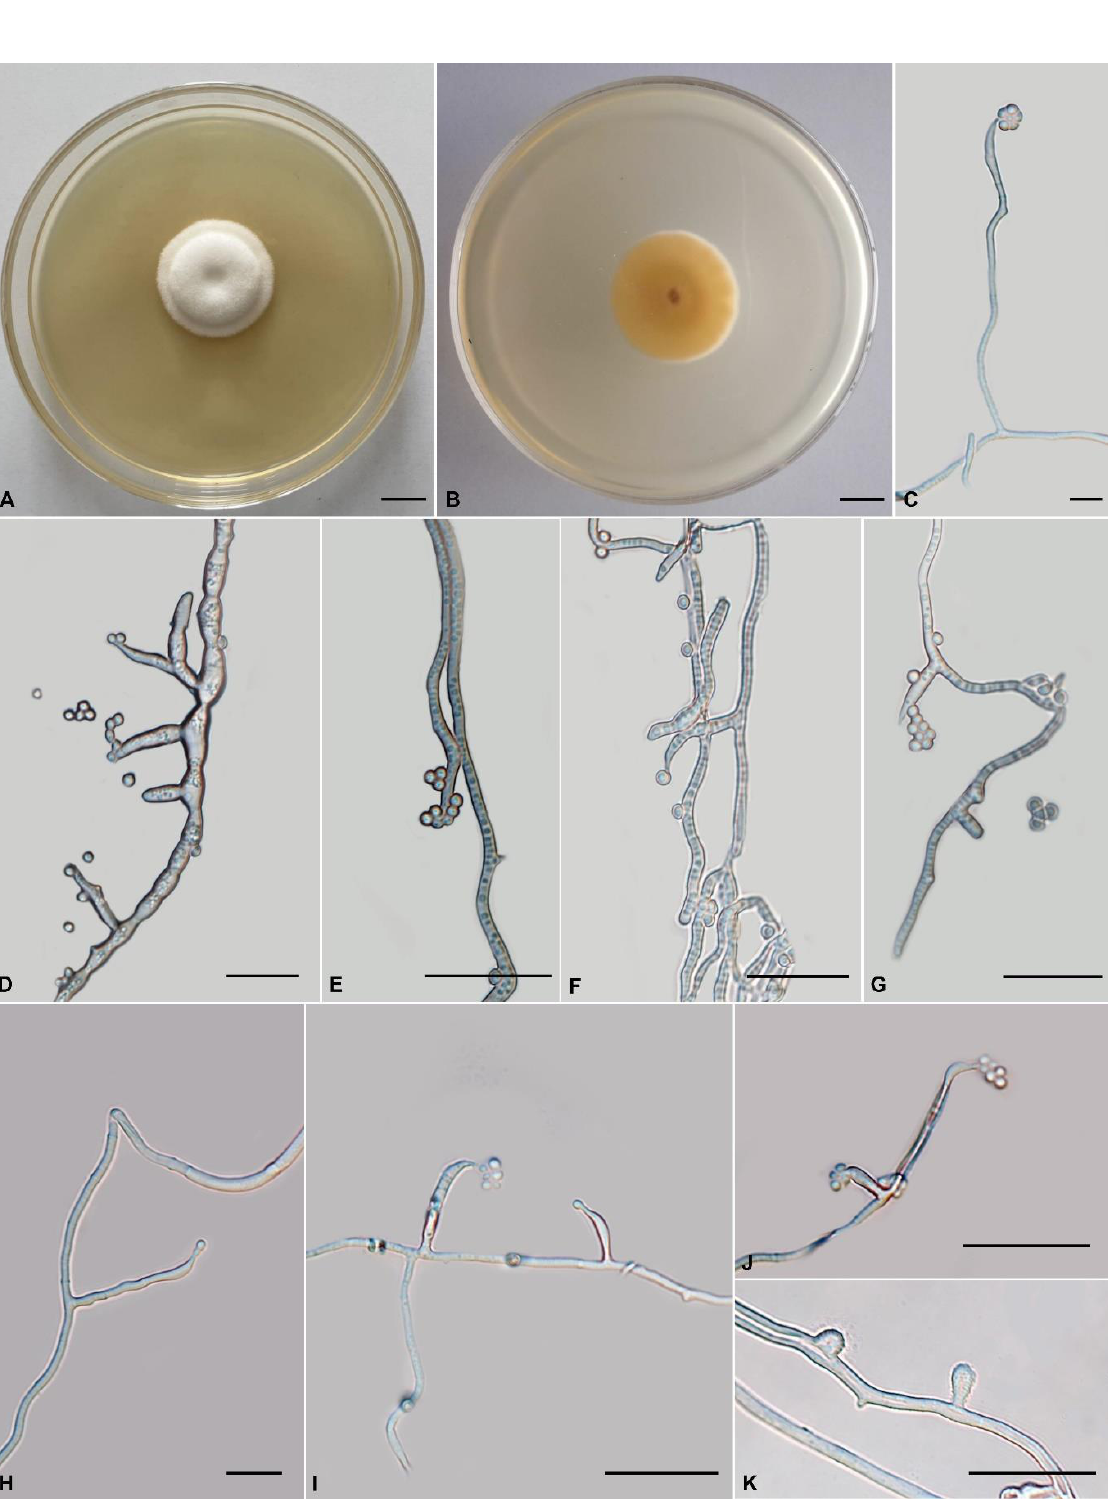
Figure 5. Morphology of Tolypocladium yunnanense (YFCC 877, ex-type living culture). ( A , B ) Cul- ture characteristics on PDA medium incubated at 22 °C for 14 days; ( C – J ) phialides and conidia; ( K ) chlamydospore. Scale bars: A – B = 10 mm; C, H = 10 μm ; D – G, I – K = 20 μm. MycoBank: MB 845432. Etymology: Yunnanense (Lat.) refers to the type locality (Yunnan,